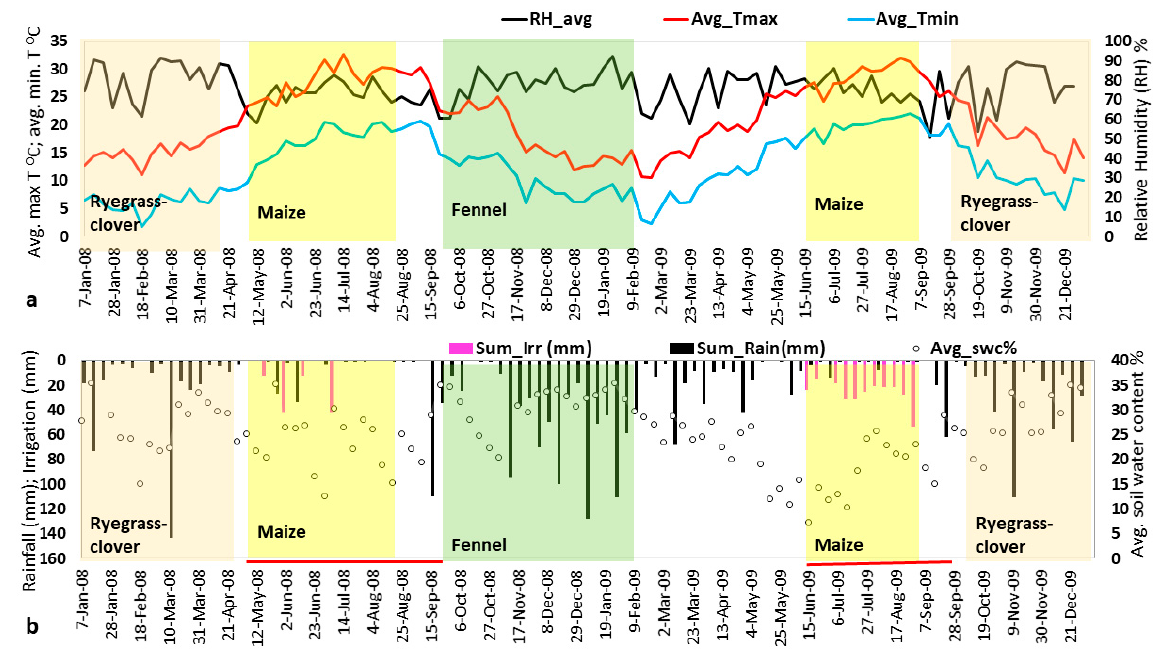
Figure 3. ( a ) Presenting weekly averages of minimum and maximum air temperature and relative humidity on the y -axis